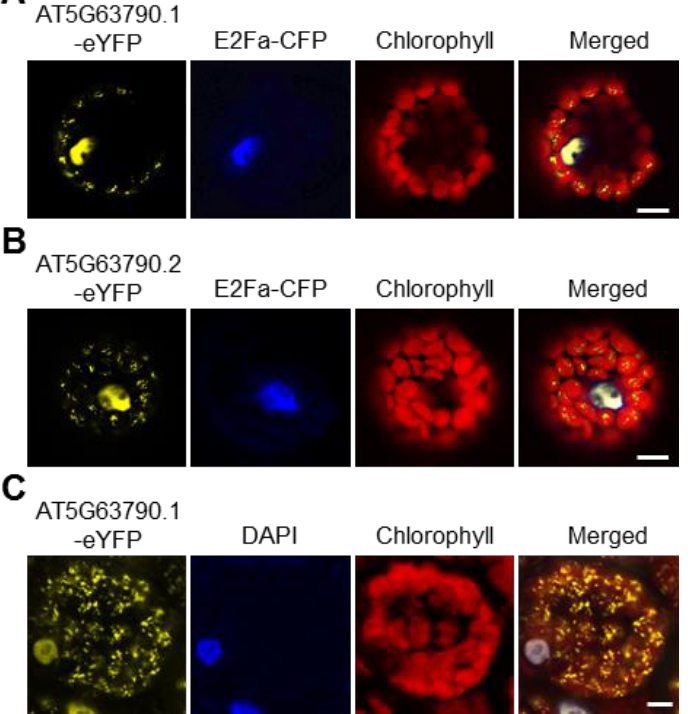
Figure 2. NAC102 localizes in both the nucleus and the chloroplast. ( A , B ) The localization of NAC102-eYFP when it was transiently expressed in Arabidopsis protoplasts. E2Fa-CFP was used as the nucleus marker and the chlorophyll fluorescence was used as the chloroplast marker. Both isoforms of NAC102, AT5G63790.1 ( A ) and AT5G63790.2 ( B ), were shown. ( C ) The localization of NAC102-eYFP in epidermal cells derived from NAC102 (AT5G63790.1) transgenic lines. The nucleus was stained with DAPI. The pictures were captured using confocal microscopy. Bars = 10 µm.